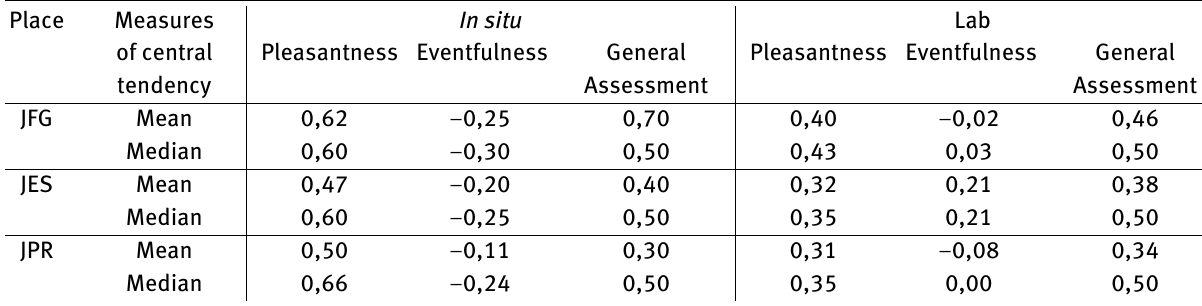
Table 6: Mann-Whitney test for the analysis of differences between experts and non-experts. Local Statistics General Pleasant Chaotic Exciting Uneventful Calm Annoying Eventful Mono- Assessment JFG Mann-Whitney U Exact Sig. [2*(1-tailed Sig.)] JES Exact Sig. [2*(1-tailed Sig.)] Exact